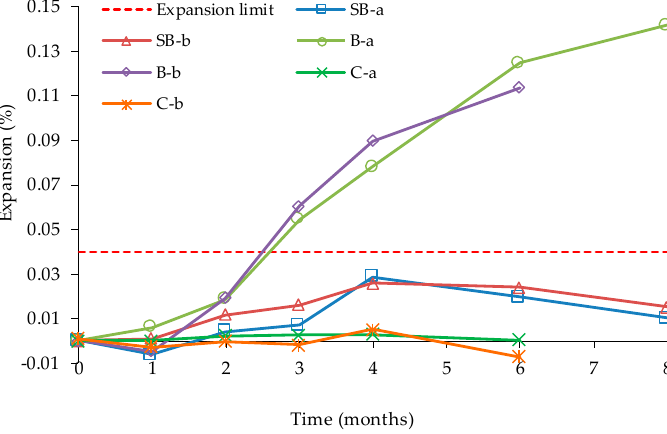
Figure 11. Evolution of expansion of selected aggregates in NF P 18-587, adapted from [83].